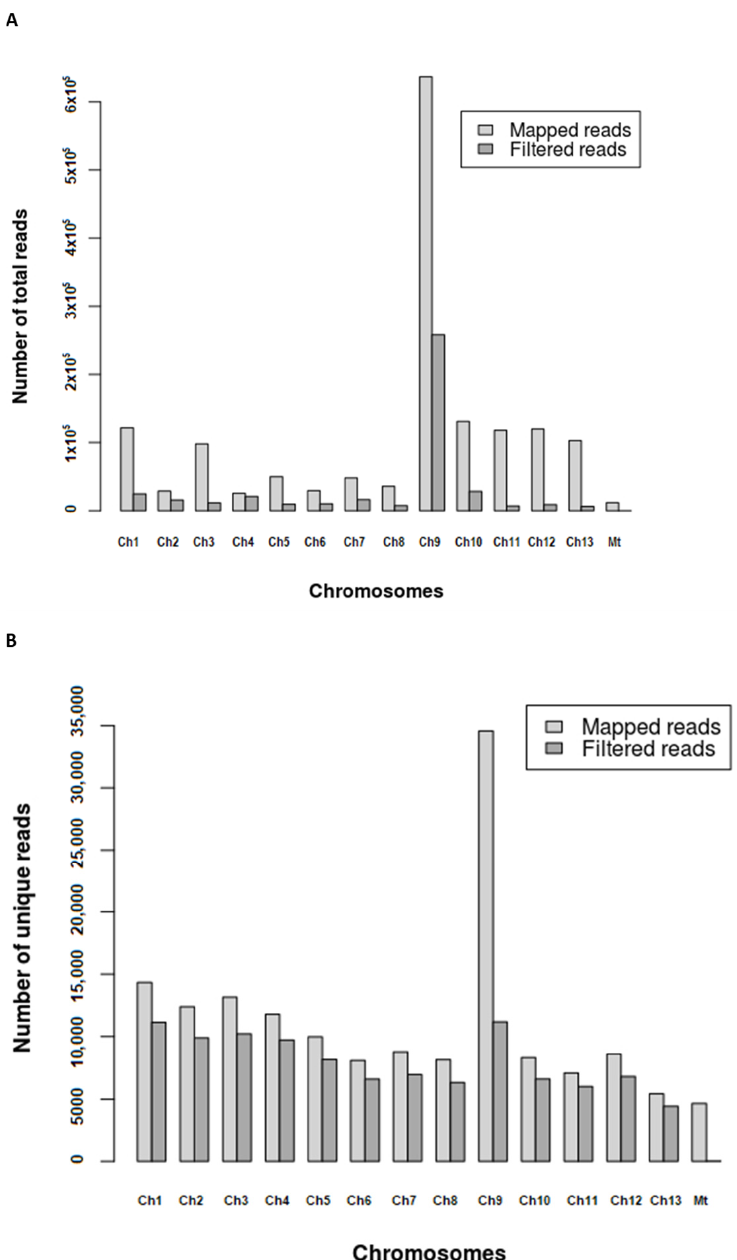
Figure 2. Read distribution on chromosomes (Ch) and mitochondrion (Mt) after mapping. ( A ) Distribution of total reads before and after removing ncRNAs. ( B ) Distribution of unique reads before and after removing ncRNAs.